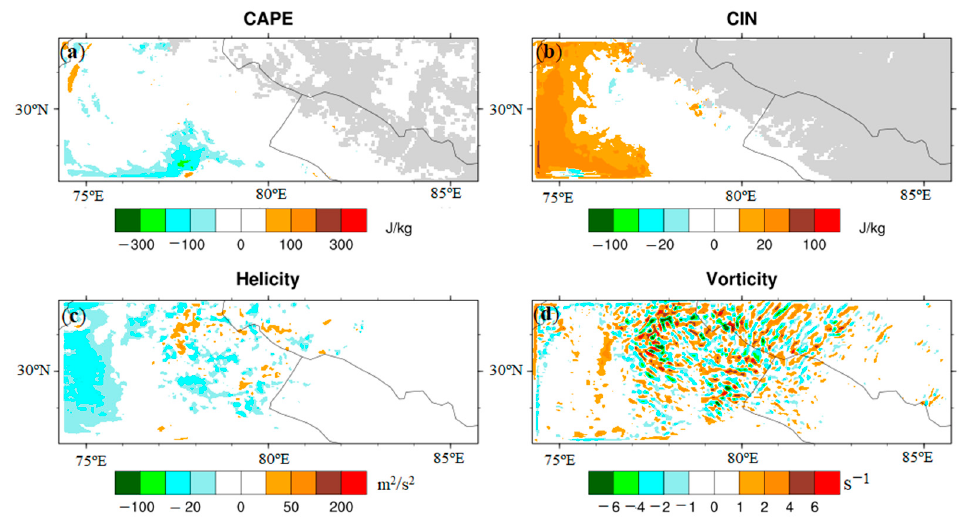
Figure 7. Effect of aerosols on ( a ) CAPE, ( b ) CIN, ( c ) helicity, and ( d ) vorticity at 4 km resolution (WC4-WRF4) during 17